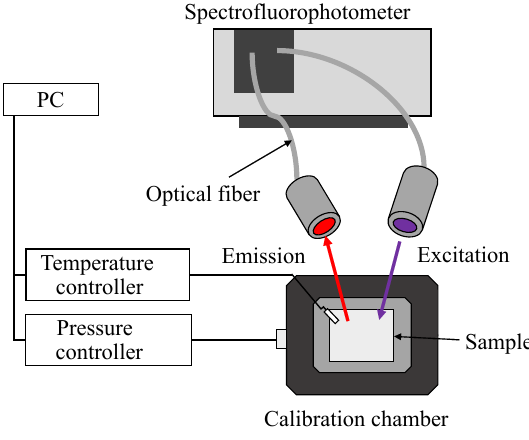
Figure 3. Schematic diagram of the measurement setup.